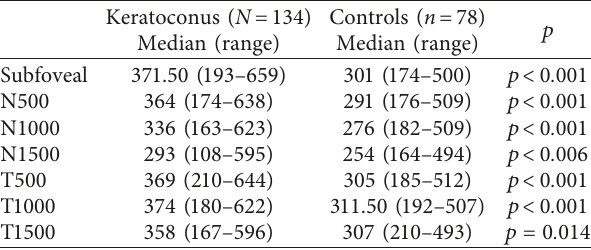
Table 3: Choroidal thickness in different locations by group. Keratoconus ( N � 134) Controls ( n � 78)